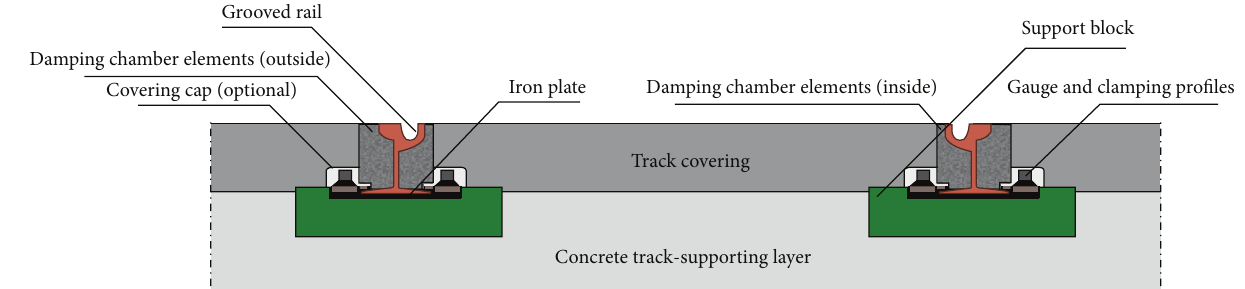
Figure 1: Cross section of the modern tram track